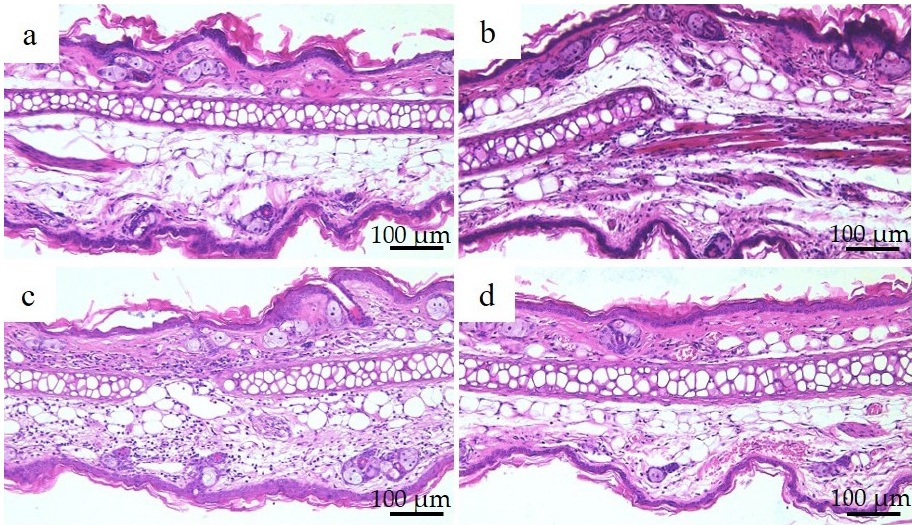
Figure 8. Auricular histology in each group after nickel allergy elicitation. ( a ) PBS, ( b ) Ion, ( c ) nickel nanoparticle (Ni-NPs), and ( d ) nickel microparticle (Ni-MPs) groups. Results of histological observations based on hematoxylin and eosin staining showed chronic inflammatory cell infiltration, which was mainly composed of lymphocytes in the Ion, Ni-NPs, and Ni-MPs groups, which was particularly pronounced in the Ni-NPs group.